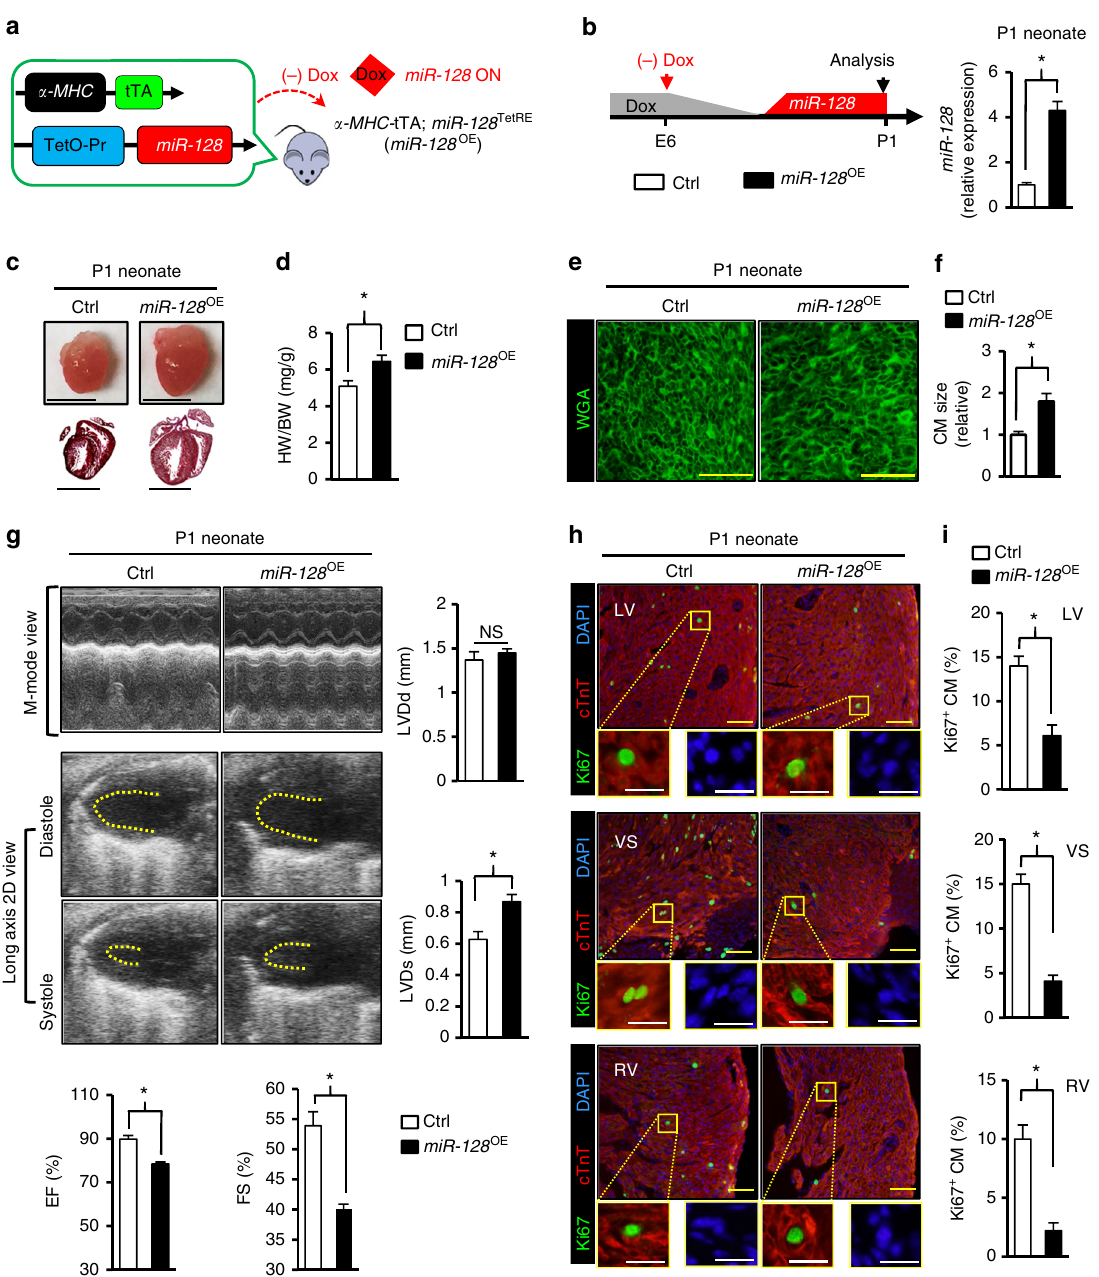
Fig. 2 Overexpression of miR-128 in cardiomyocytes impairs cardiac homeostasis. a Schematic showing the generation of mice that overexpress CM- speci fi c miR-128 after doxycycline (Dox) withdrawal. Control mice were miR-128 TetRE mice, and miR-128 OE mice were α -MHC -tTA; miR-128 TetRE mice. b Schematic of experimental design for CM-speci fi c overexpression of miR-128 at P1 (left panel). Right panel shows the qPCR analysis of miR-128 expression in Ctrl and miR-128 OE mice ( n = 5). c Gross morphology (upper panel) and Masson trichrome staining (lower panel) of hearts at P1. Scale bars, 0.25 cm (upper panel); 1 mm (lower panel). d Heart weight (HW) to body weight (BW) ratio of P1 mice ( n = 8). e Wheat germ agglutinin (WGA) staining of P1 neonatal hearts. Scale bars, 25 µ m. f Quanti fi cation of CM size as determined by WGA staining ( n = 8 mice, ~200 CMs/heart). g Heart function analyzed by echocardiography in P1 mice as measured by left ventricular end-diastolic diameter (LVDd), LV end-systolic diameter (LVDs), ejection fraction (EF), and fraction shortening (FS) ( n = 6). h Evaluation of CM proliferative activity by Ki67 immunostaining in Ctrl and miR-128 OE hearts. Scale bars, 25 µ m (yellow); 10 µ m (white). i Quanti fi cation data of CM proliferative activity by Ki67 staining in Ctrl and miR-128 OE hearts ( n = 6 mice, ~800 CMs/heart). Statistical signi fi cance was calculated using Student ’ s t -test. Data are represented as means ± SEM. * P <